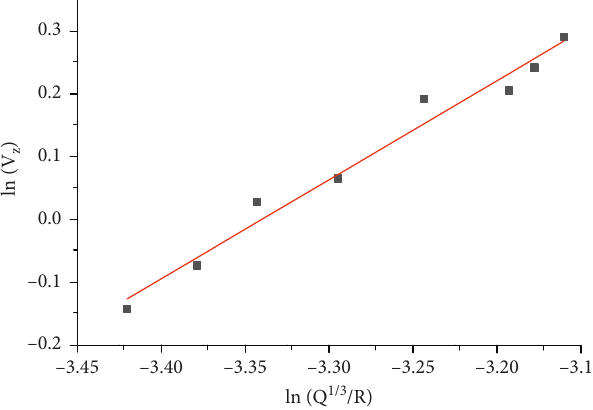
Figure 9: Least squares regression curve of blasting